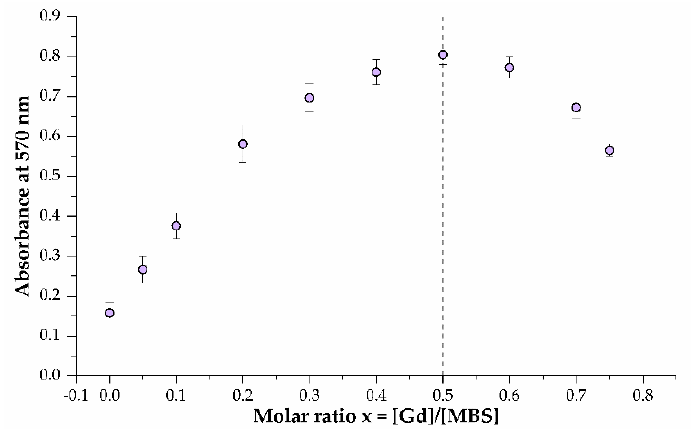
Figure 7. Job graph for Gd 3+ binding to the E2-13W4 protein. The observed maximum at x = 0.5 corresponds to a stoichiometric ratio of 1:1. The results are represented as arithmetic means, and the error bars represent standard deviations ( n = 3).